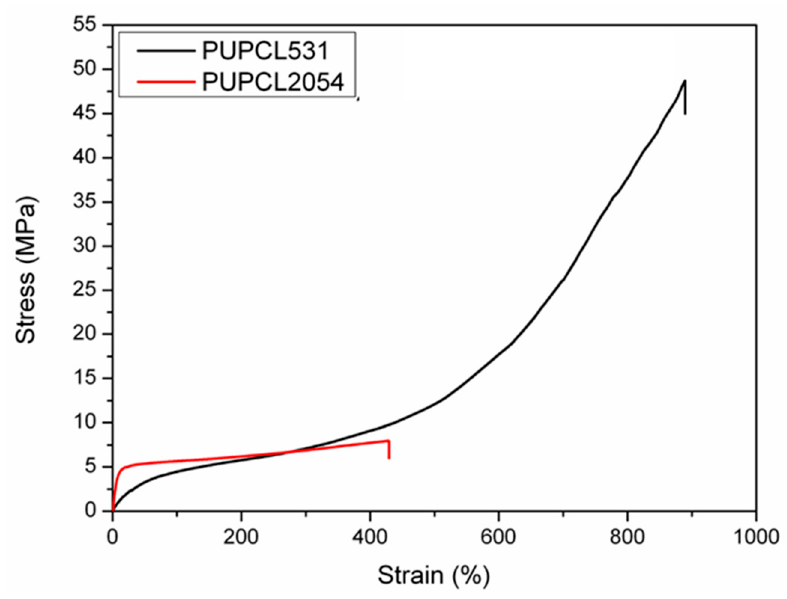
Figure 5. Stress–strain curves for PUPCL531 and PUPCL2054.